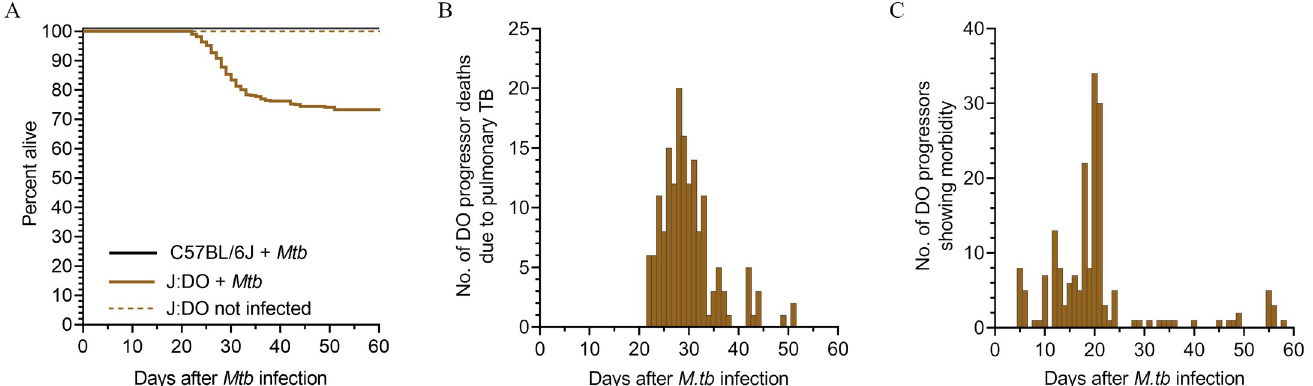
Fig 1. Survival, deaths due to pulmonary TB, and morbidity onset. We infected 8-10-week-old, female DO (n = 657) and C57BL/6J (n = 66) mice with ~25 Mtb bacilli by inhalation, monitored for health daily, and euthanized the progressor DO mice that developed any one of three IACUC-approved morbidity criteria: body condition score < 2; severe lethargy; or respiratory distress (i.e. increased respiratory rate and effort). Within 60 days, 34% of DO mice succumbed to pulmonary TB and required euthanasia due to pulmonary TB (progressors), while 66% survived (controllers). All non-infected DO mice (n = 40) and all Mtb- infected C57BL/6J inbred mice survived 60 days without morbidity or mortality ( p < 0.0001 by Log-rank Mantel-Cox test) (A). When progressor DO succumbed, a mortality wave occurred between 21–52 days and peaked 25–35 days (B). Morbidity in progressor DO mice began as early as 4 days after Mtb infection and peaked at 18 days post- infection